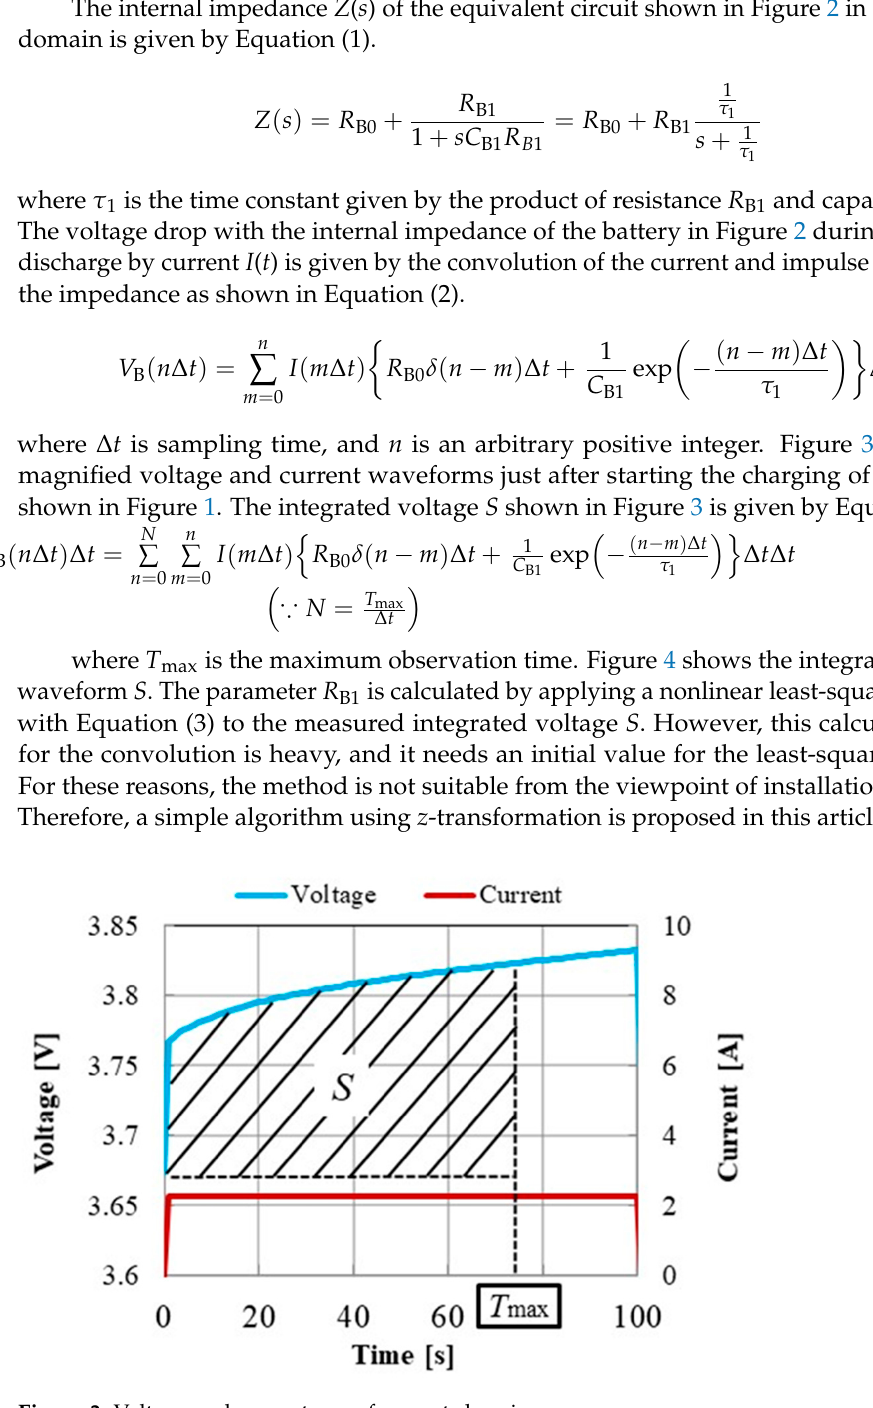
Figure 3. Voltage and current waveforms at